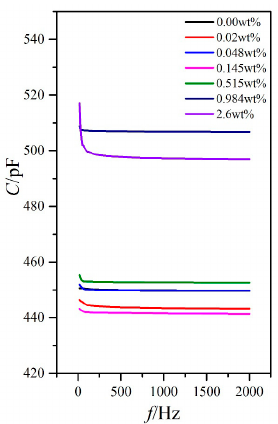
Figure 6. PAN cell capacitance versus frequency with different doped γ -Fe 2 O 3 nanoparticle concentrations under the external voltage of 1 V and temperature of 25 °C.